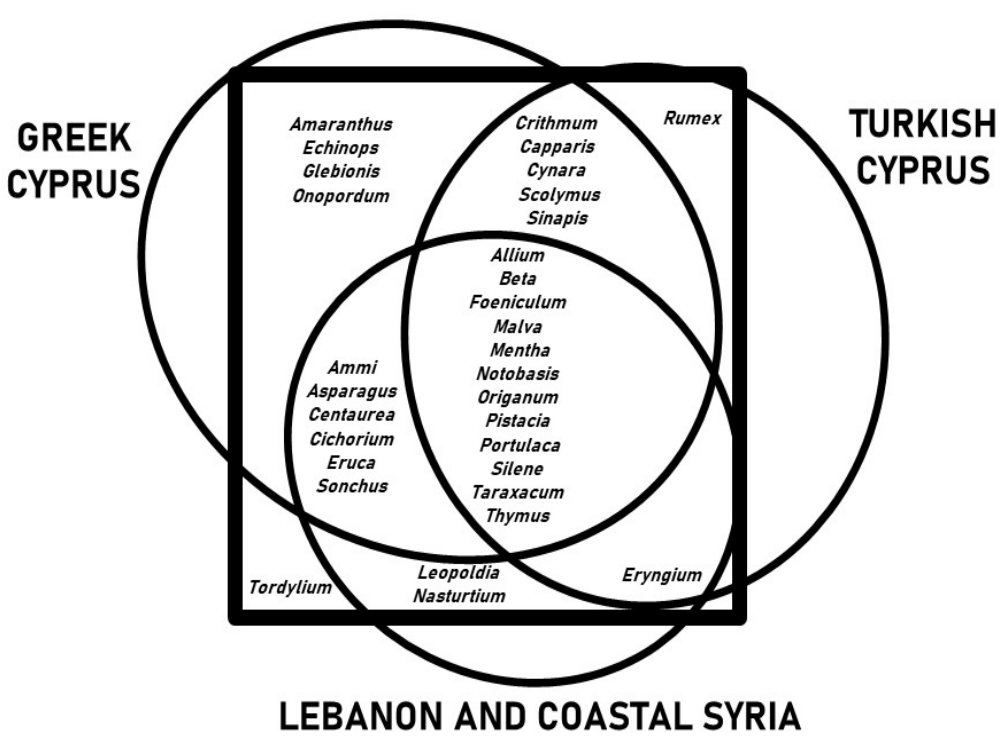
Figure 4. Venn diagram showing the overlap between the wild vegetables gathered and consumed in Kormakitis, and those recorded among Greek and Turkish Cypriots, and among Arabs in Lebanon and coastal Syria.